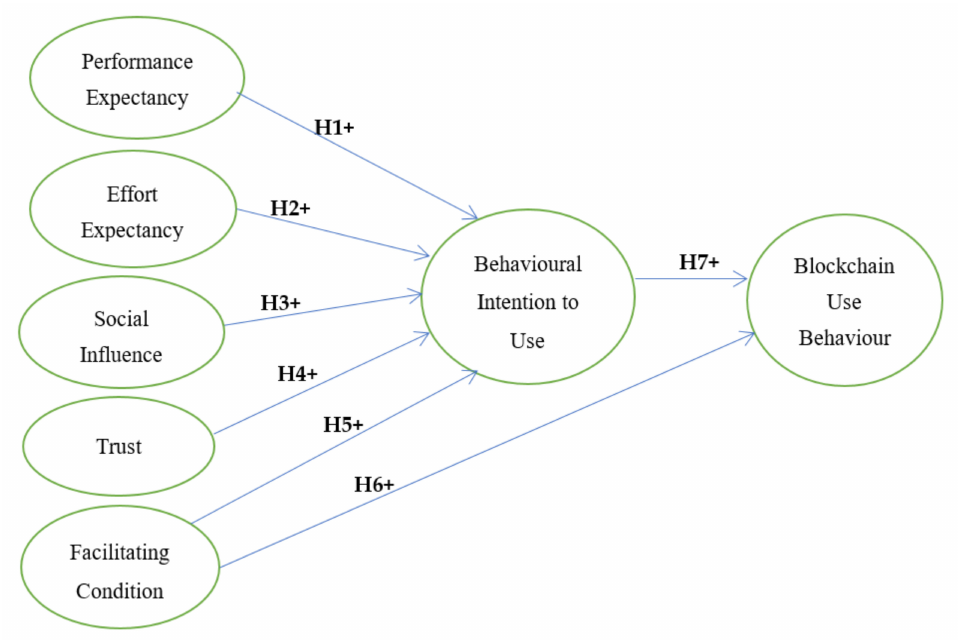
Figure 1. Research framework explaining blockchain adoption drivers for supply chain